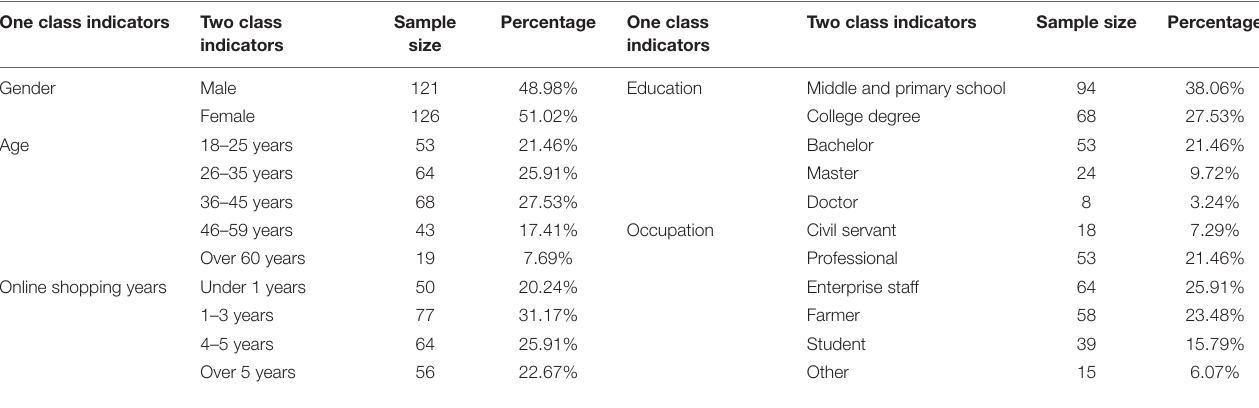
TABLE 2 | Test for reliability, convergent, and construct